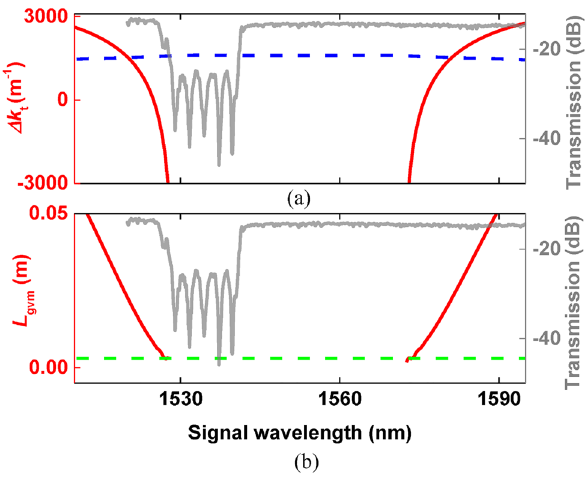
Figure 3: (a) Phase mismatch ( Δ k t ) in the CMBGs (red solid line) and WG (blue dashed line) as a function of signal wavelength. The pump wavelength is 1550 nm and the signal wavelengths are varied between1510 – 1528and1573 – 1595nm.Forthe Δ k t curveatashorter signal wavelength of 1510 – 1528 nm, the signal wavelength is locatedclose to Bandedge1 to optimizethe phasemismatch.Forthe Δ k – 1595 nm, generated t curve at a longer signal wavelength of 1573 idler wavelengths are tuned close to Bandedge1 to optimize the phase mismatch. The pump is located near Bandedge2 to minimize Δ k t . The 5 ps pump peak power is 1.6 W. (b) The group velocity matching length ( L gvm ) is de fi ned as τ / | 1/ v p − 1/ v s,i | , where τ is pulse widthand v p , v s,i arevelocitiesforpump,signal,andidlerbeam. L gvm is larger than the device length of 3 mm (green dashed). Gray lines depict linear transmission in the dB scale as a function of